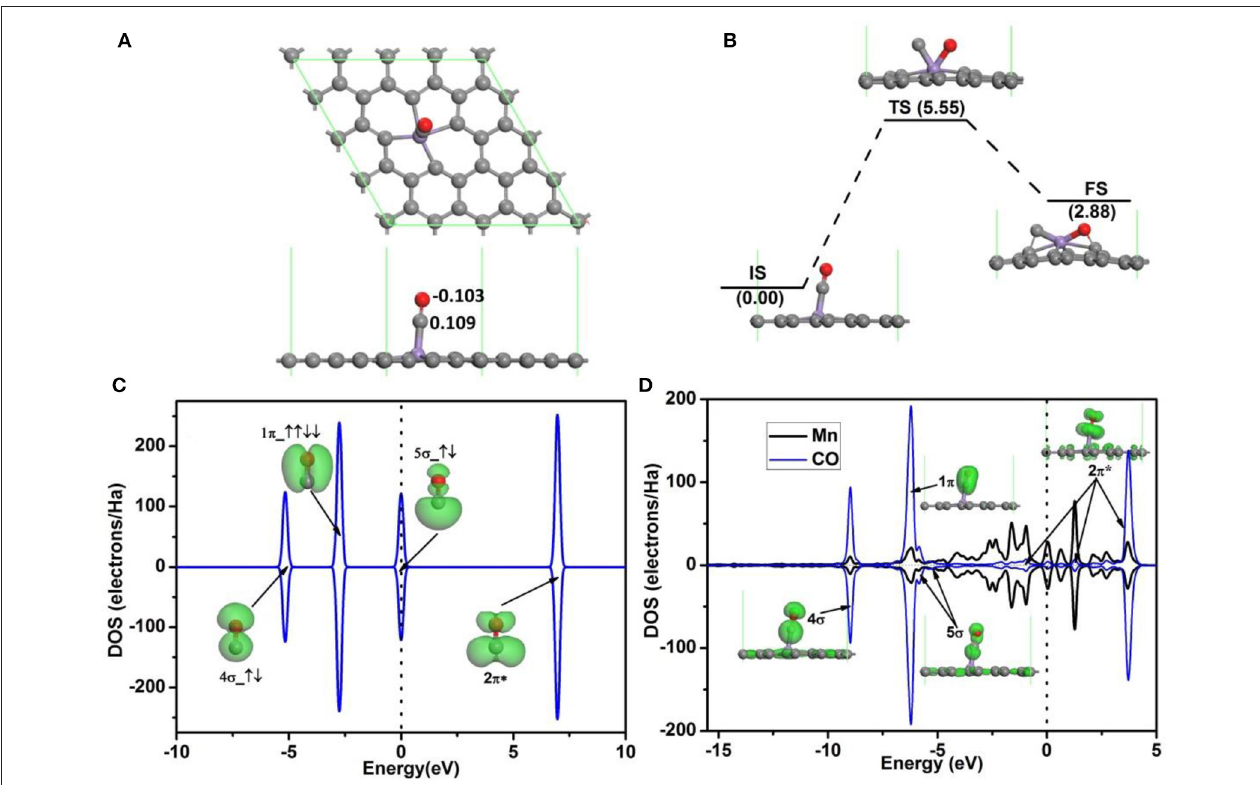
FIGURE 4 | (A) The most stable structure of CO adsorbed on Mn-DG. (B) The reaction pathway for the dissociative adsorption of CO molecule on Mn-DG. (C) PDOS and orbitals of the free CO molecule, where the number of electrons for each orbital is also shown by arrows. (D) PDOS of the adsorbed CO molecule and Mn atom for the Mn-DG, inset is the charge density of 4 σ , 1 π , 5 σ , and 2 π * orbitals of the adsorbed CO molecule. The vertical lines indicate the Fermi